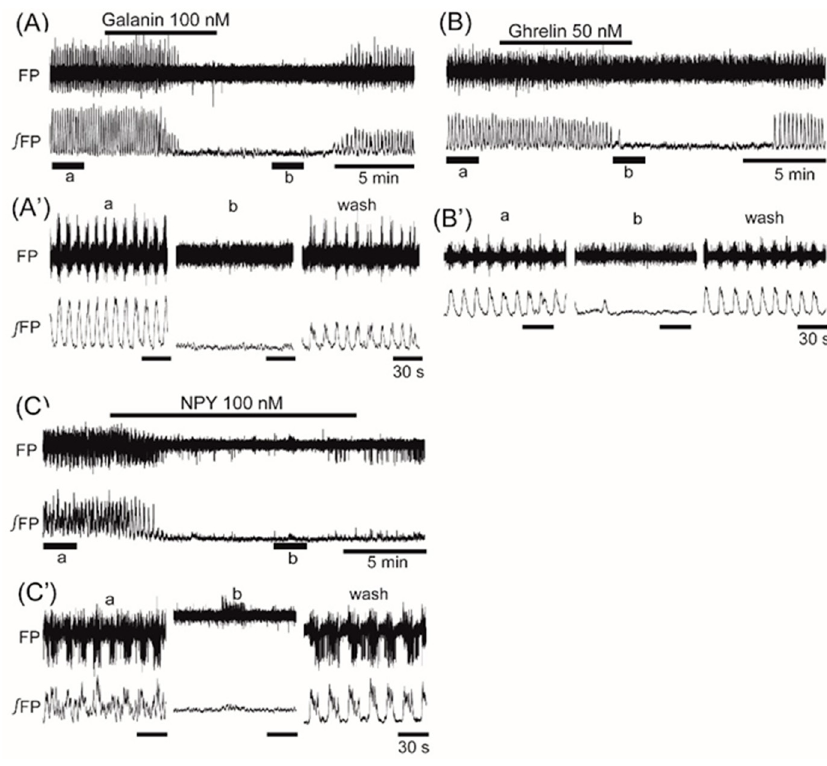
Figure 6. The effects of orexigenic neuropeptides galanin, ghrelin, and neuropeptide Y (NPY) on oscillation in the ventromedial hypothalamus. ( A – C ) Examples of continuous recordings of the ventromedial hypothalamus field potential before and after application of 100 nM galanin, 50 nM ghrelin, and 100 nM NPY, respectively. ( A’ – C’ ) Faster sweep representations: a and b correspond to records at “a” and “b” in ( A – C ), and after 20-min washout (wash). The frequency of the oscillation was inhibited by the application of each of the peptides.